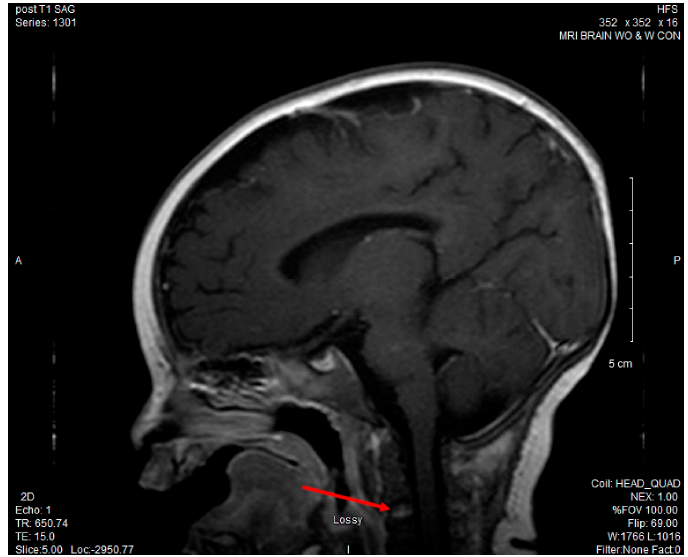
Figure 1. Magnetic resonance imaging (MRI) brain with and without contrast: increased T2 enhancement of the C3 vertebral body concerning for osteomyelitis.